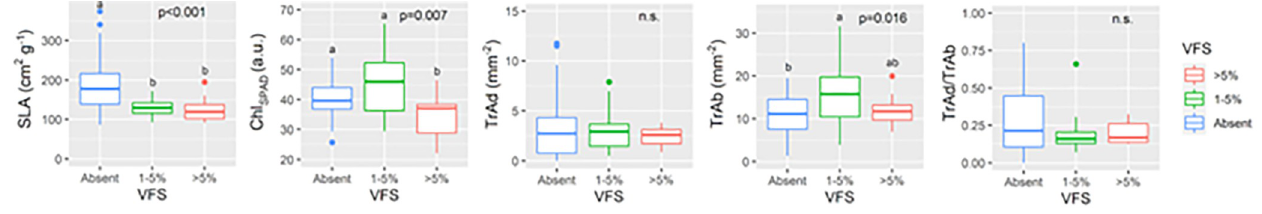
Fig 5. Leaf traits for symptomatic plants at different levels of visible foliar symptoms (VFS). SLA: specific leaf area; Chl SPAD : chlorophyll content measured with the chlorophyll meter SPAD; TrAb: abaxial trichomes density; TrAd: adaxial trichomes density; TrAd/TrAb: ratio between adaxial and abaxial trichomes density. Whiskers indicate the ranges of the minimum and maximum values; data were analysed with one-way ANOVA (n = 10–43) and p-value is shown in each graph. Different letters indicate significantly different values according to Fisher’s test.